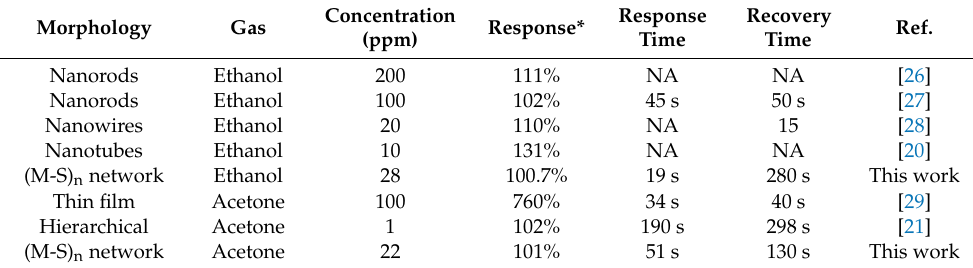
Table 1. Room-temperature ethanol and acetone gas sensors using ZnO nanomaterials.